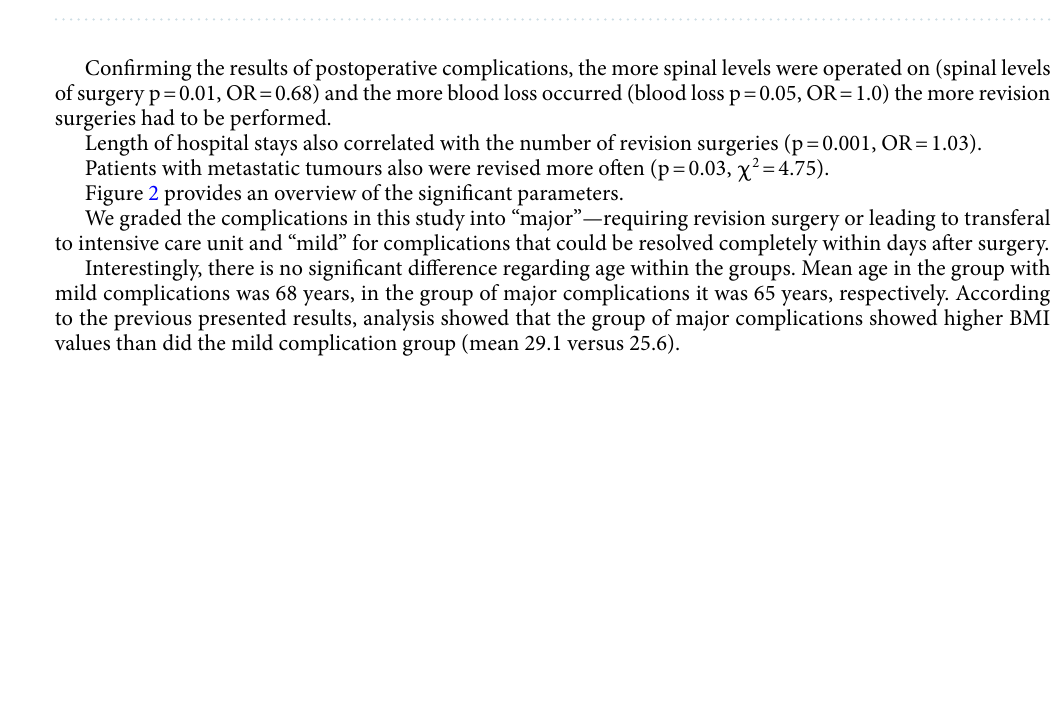
Figure 2. Significant risk factors for complications during patients’ hospital